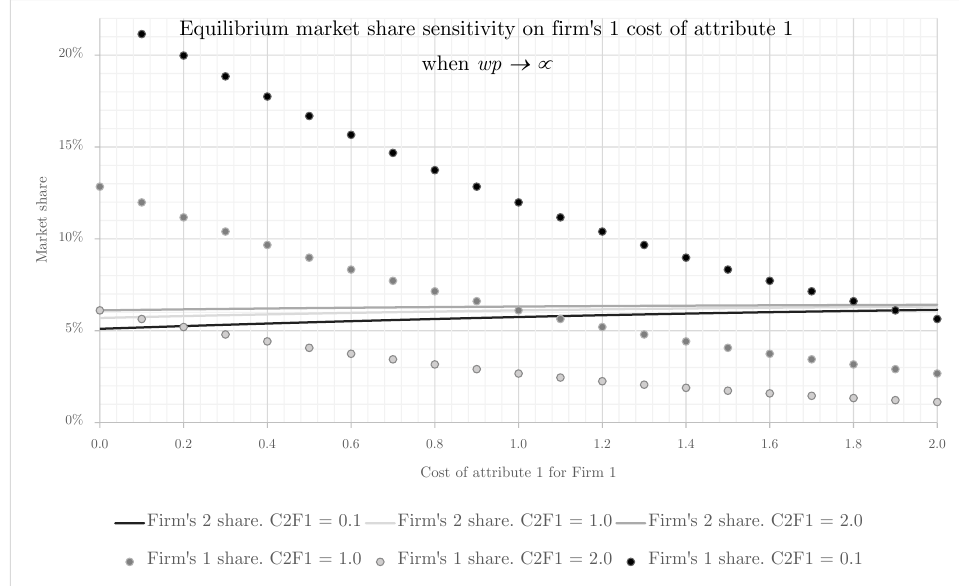
Figure A4. Firms’ market share varying attributes’ cost of Firm 1 when wp (cid:29) 0.